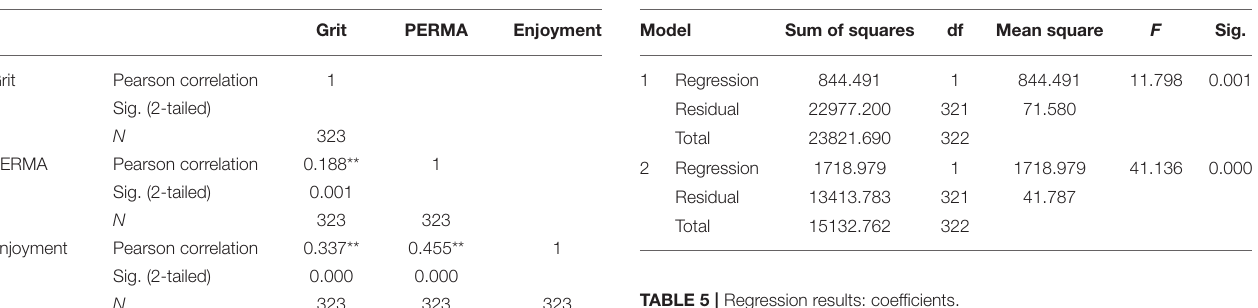
TABLE 2 | Pearson correlations among the variables.